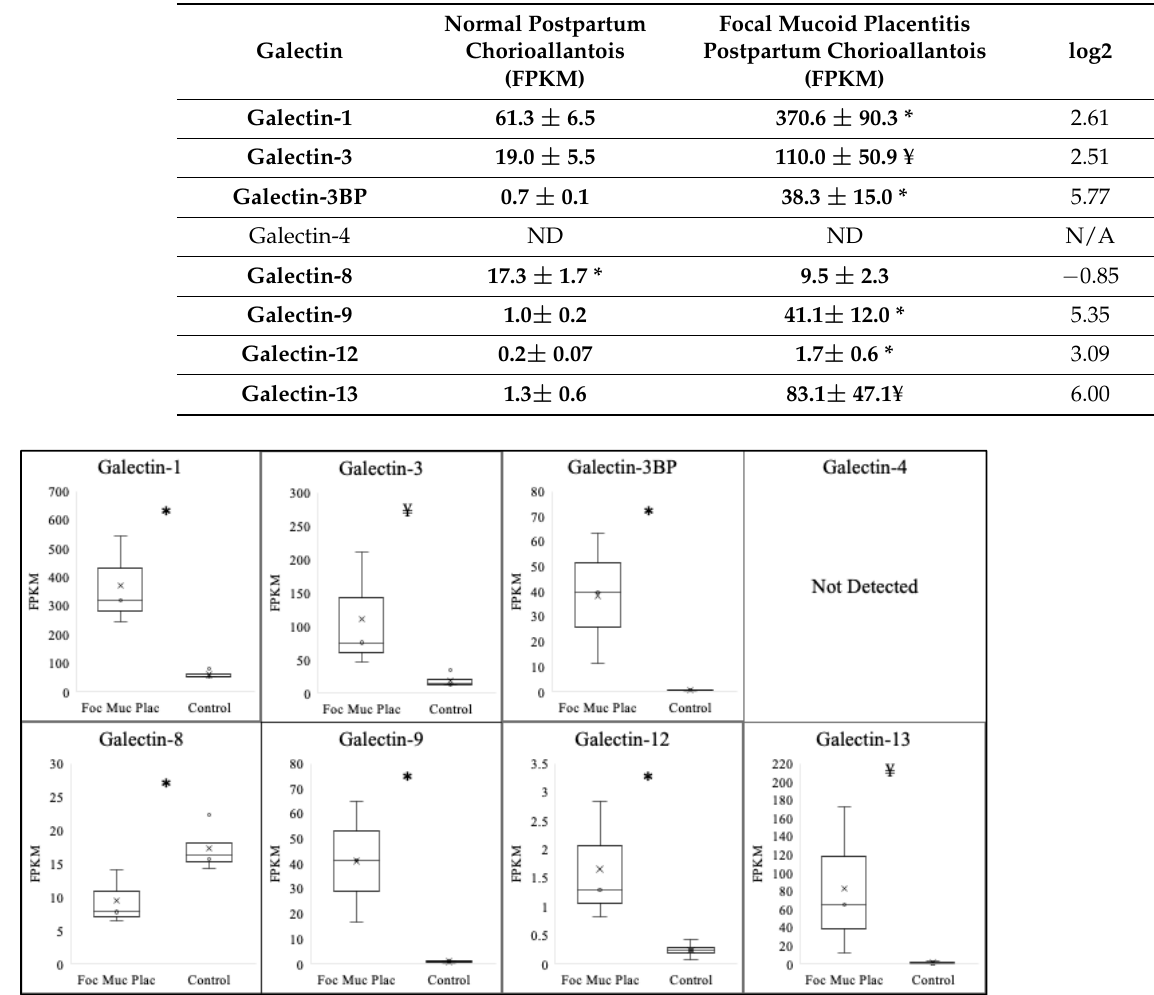
Table 2. Expression of various galectins following focal mucoid placentitis. FPKM = fragments per kilobase measured. * p < 0.05, ¥ < 0.10, ND = no detectable expression.